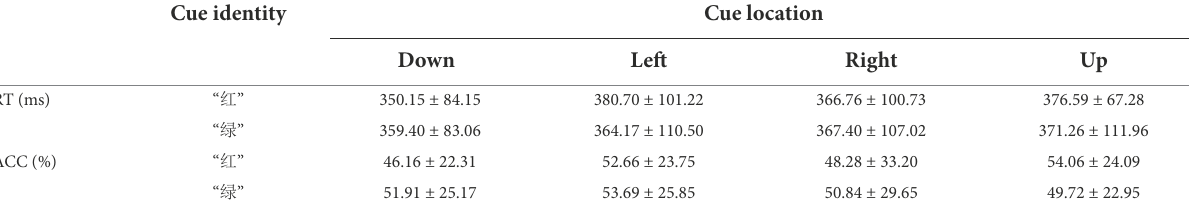
TABLE 1 Average reaction times and accuracy rates under the combinations of the cue identity and the cue location in the pre-experiment (M ±